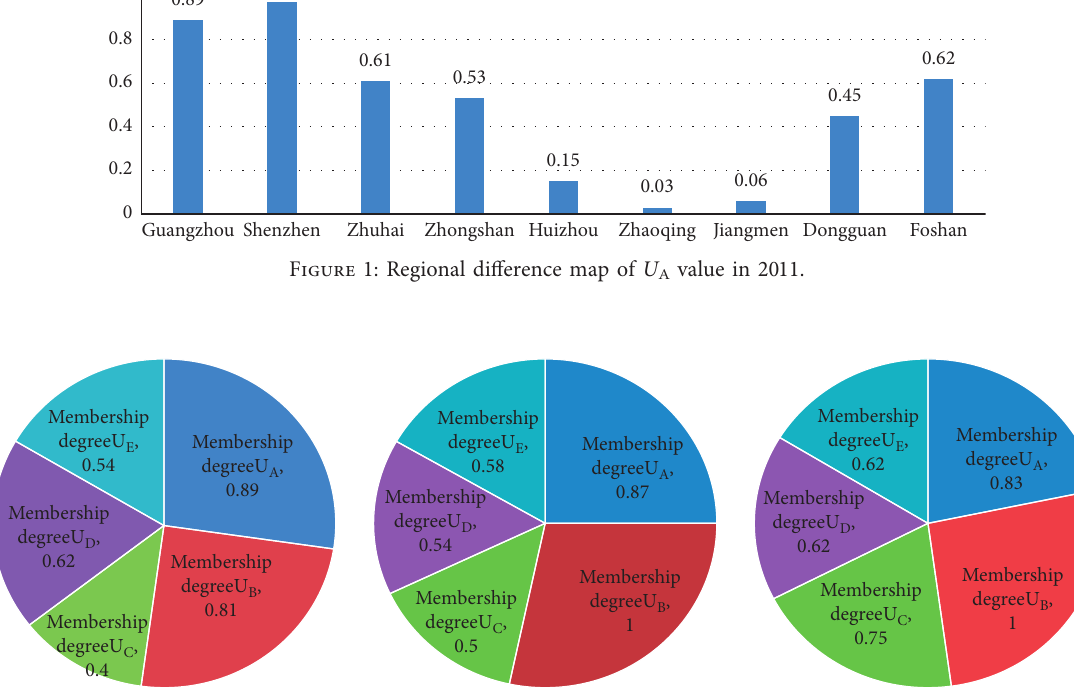
Figure 2: Evolution of the composite structure of the membership degree of the primary index of the happiness index of Guangzhou